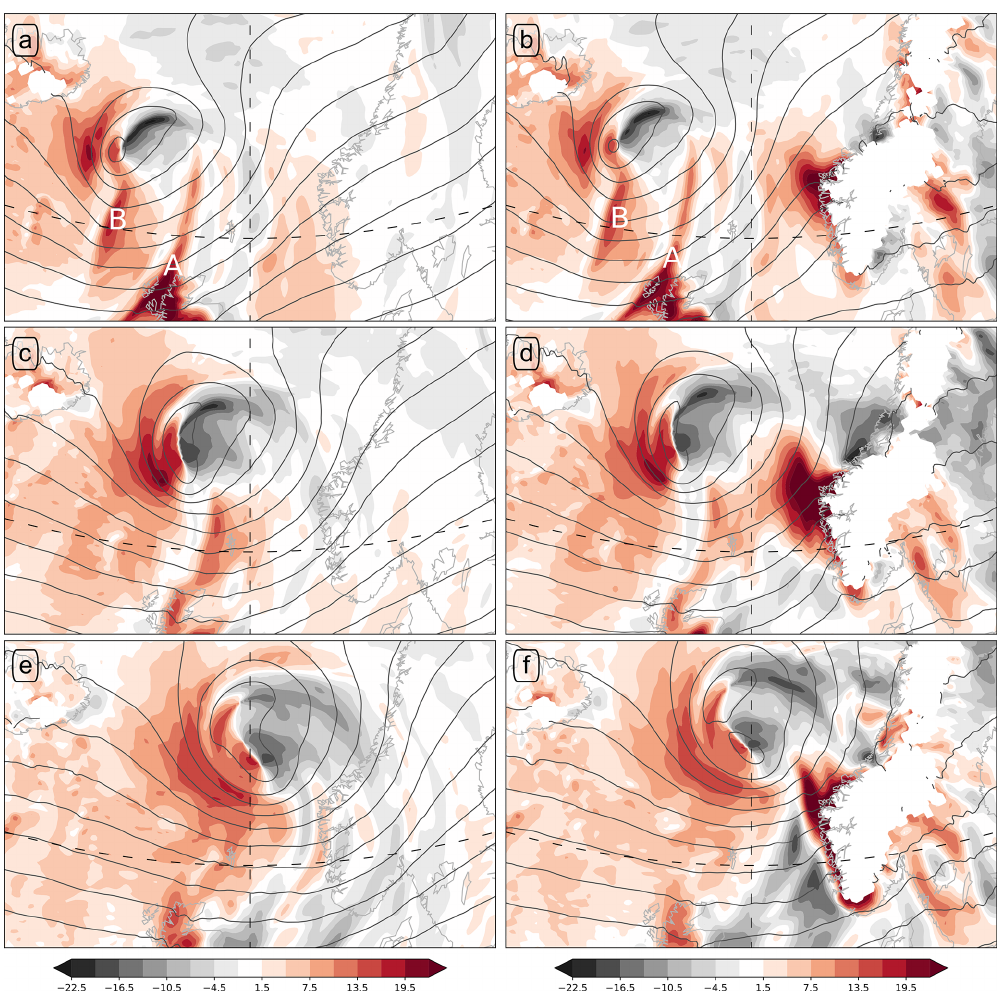
Figure 8. Mass transport (kgs − 1 m − 2 ) perpendicular to geopotential isolines at 850hPa, with positive values indicating transport towards lower geopotential. The rows show the time evolution for (a, b) 00:00UTC, (c, d) 03:00UTC, and (e, f) 06:00UTC. Panels (a, c, e) are based on a WRF simulation in which the Scandinavian orography as been removed and converted to ocean. Panels (b, d, f) are based on a WRF simulation in which the Scandinavian orography is twice its original height. For the meaning of “A” and “B”, refer to the main text.